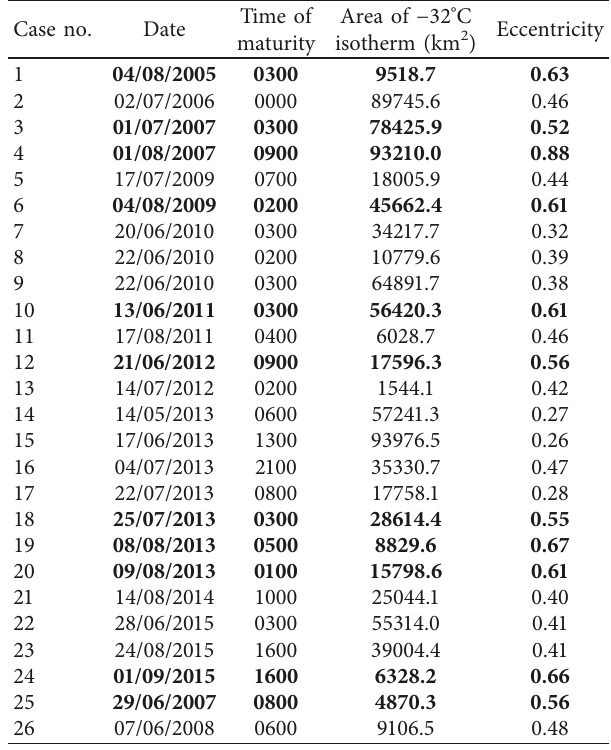
Table 2: Statistics of the M β CS occurrences during 2005 to 2015. Case